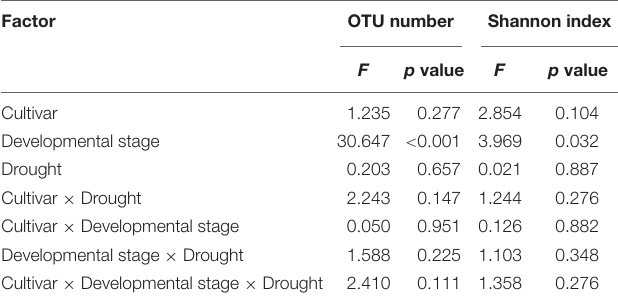
TABLE 2 | Results of three-way ANOVA on the effects of cultivar, drought stress, and developmental stage on the richness and evenness of the bacterial community within the rhizosphere of broomcorn millet ( n = 3).